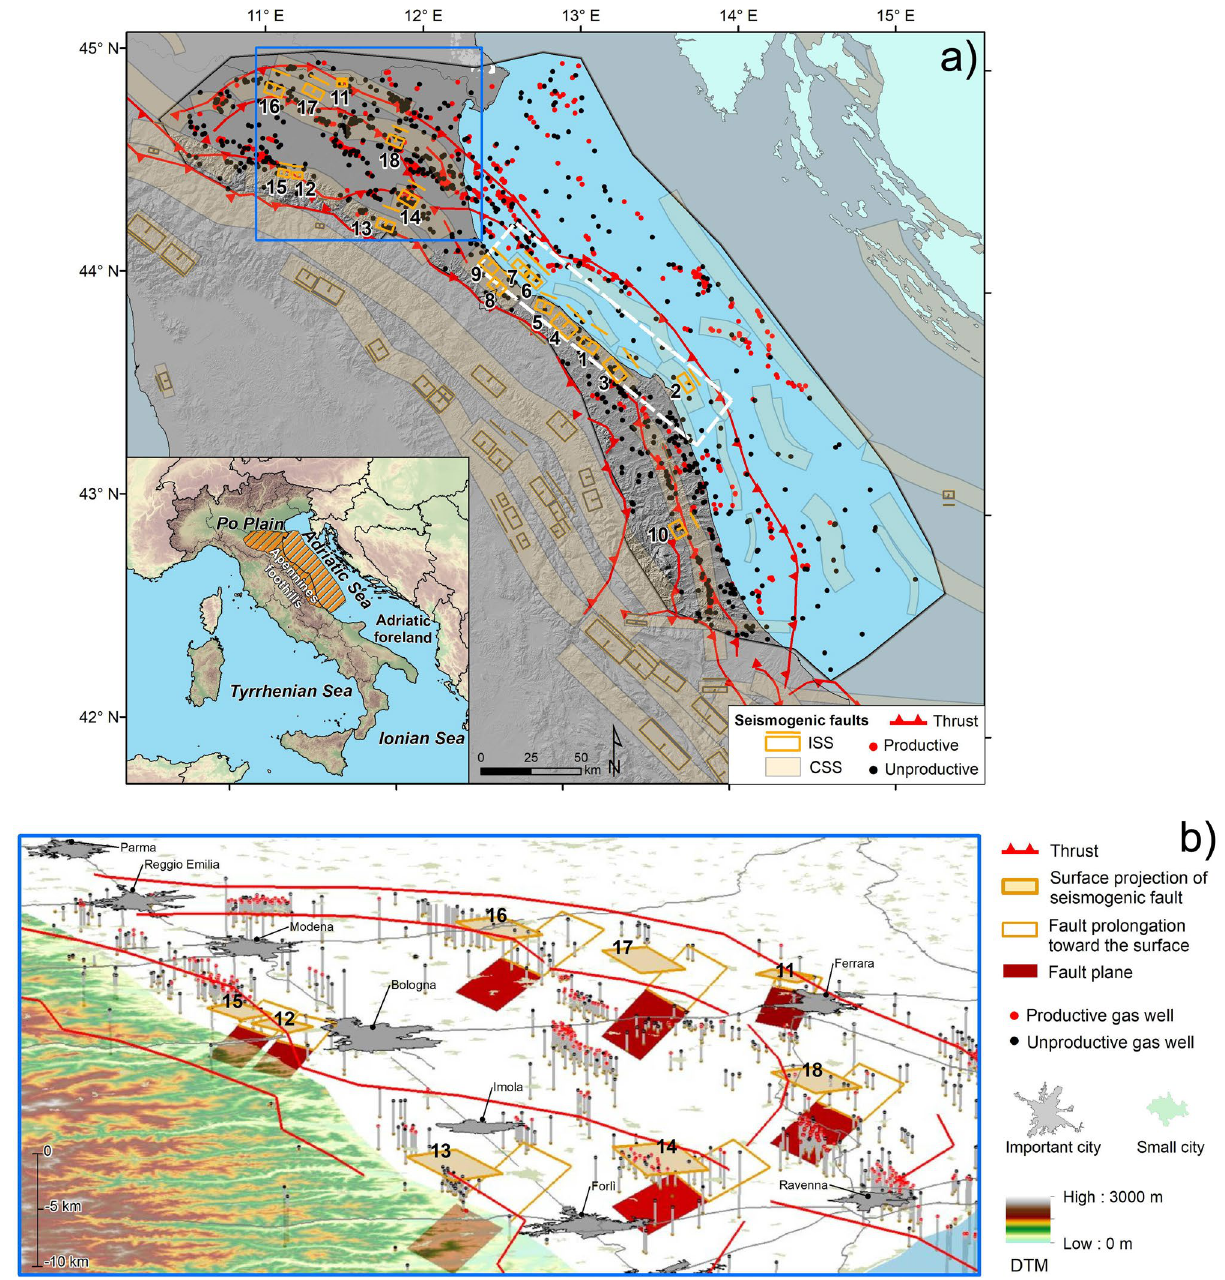
Figure 1. Overview of the study area, showing the location of selected gas wells and seismogenic faults. ( a ) The study area, shown by a black polygon, was delineated following the structural scheme proposed by Mantovani et al. 17 . Gas reservoirs are selected from the ViDEPI database and lie mostly within the external foothill belt between the leading thrusts of the internal zone and the outermost thrusts in the Adriatic foreland basin. The empty boxes are the surface projections of Individual Seismogenic Sources from the DISS database: the 18 faults selected for this study are shown in orange, whereas all others are shown in brown. The elongated light brown polygons are Composite Seismogenic Sources from the DISS database. The blue box shows the location of panel ( b ). The white dashed rectangle indicates a 120 km-long coastal strip where seismic hazard is consistently higher than in structurally similar, adjacent areas of the Italian peninsula, but where there exist only fewer-than-average unproductive wells and virtually no productive wells (see text). Please refer to the “Methods” section for further details. The figure was drawn using ArcGis 10.4.1 for Desktop/ArcMap 10.4.1.5686 by ESRI (http:// www. esri. com). ( b ) Details of the geometrical calculations conducted over the northwesternmost portion of our study area. The solid orange boxes represent the surface projection of the selected faults (same as in panel a ), whose full 3D extent is shown by the red patches, which extend from the minimum to the maximum depth of seismogenic faulting reported in the DISS database (see “Methods” section). The empty orange boxes show the fault prolongation toward the surface. The vertical lines show the location and depth of the investigated gas wells, allowing the reader to appreciate their actual 3D spatial relationships with the seismogenic faults. The figure was drawn using ArcGis 10.4.1 for Desktop/ArcScene 10.4.1.5686 by ESRI (http:// www. esri.